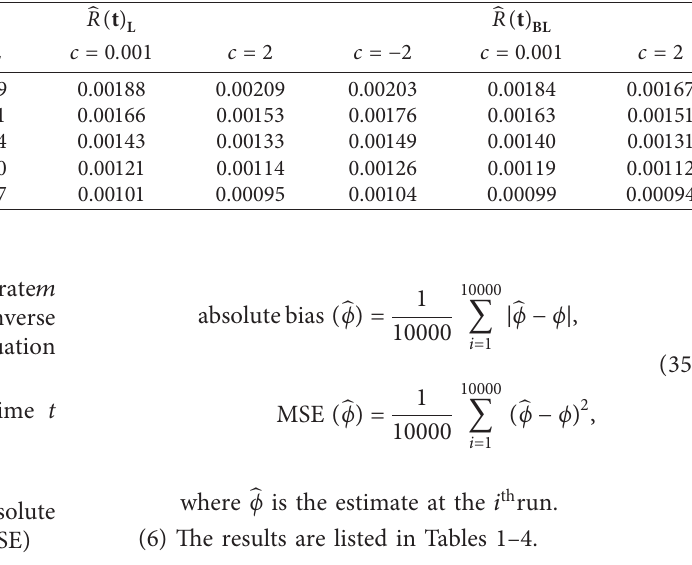
Table 4: MSEs of the estimates of R ( t ) at t � 4